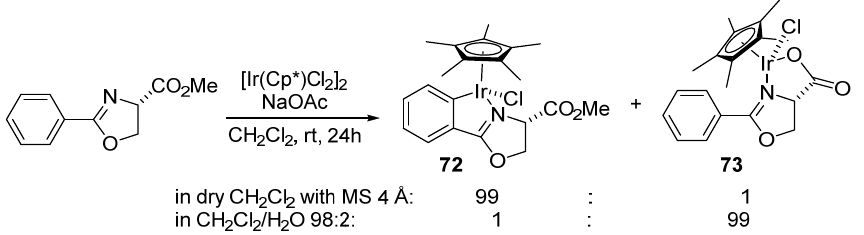
Scheme 42. Products of the cyclometalation of methyl ( S